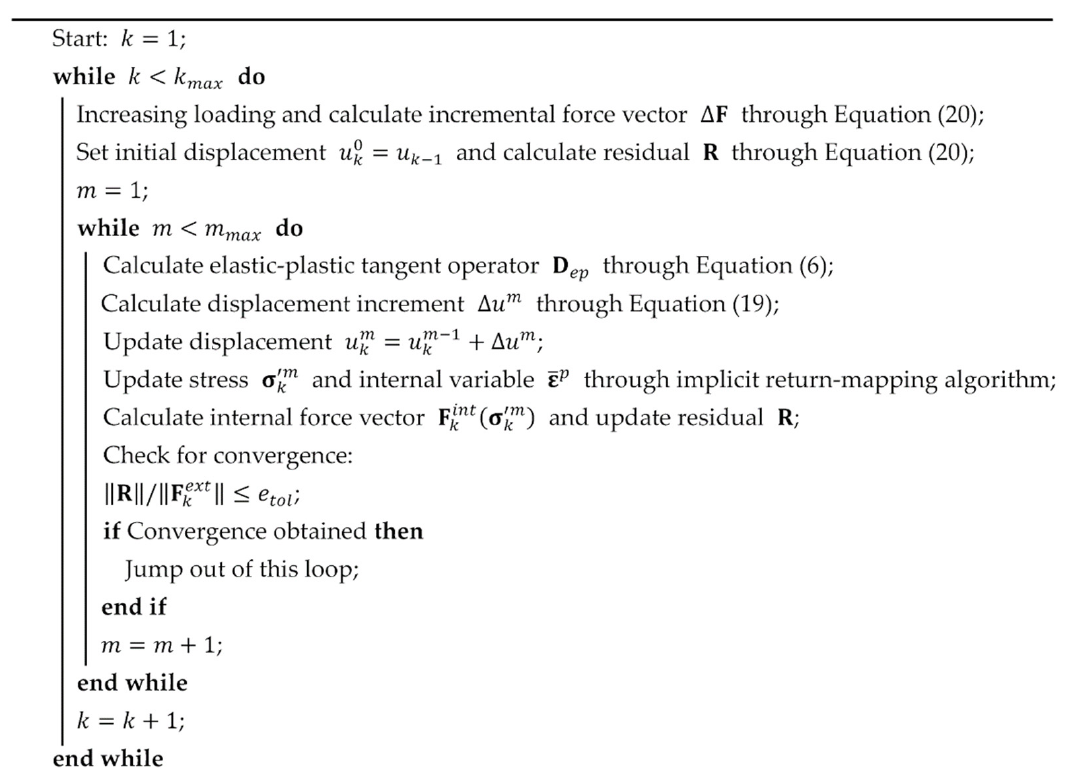
Figure 4. Overview of the iterative algorithm for solving nonlinear stress field.